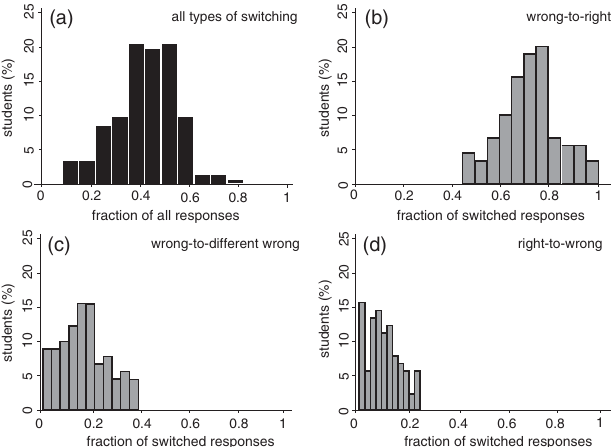
FIG. 1. (a) Fraction of all responses that are switched (top left). (b) Fraction of all switched responses that are switched from wrong to right (top right). (c) Fraction of all switched responses that are switched from wrong to a different wrong (bottom left), and (d) fraction of all switched responses that are switched from right to a wrong (bottom adjusted measure of the response switching, independent of how many times a student was right (or wrong) in round 1. Figure 2 illustrates the need for this normalization. In Fig. 2, each data point represents the relationship between the fraction of answered items that were switched from wrong to right and the number of items a student answered incorrectly in round 1. When the WR transition is not normalized with respect to the round 1 response, the number of wrong round 1 responses confounds the number